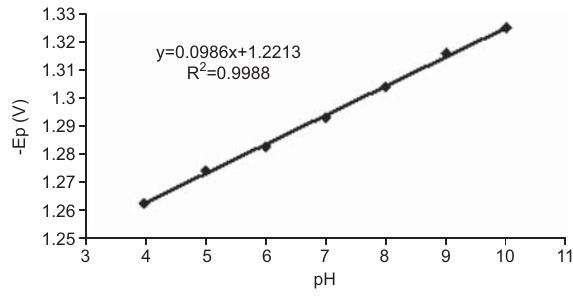
Figure 3 Plot of pH vs. peak potential for 4.76 µ g/ml EZE in the presence of K